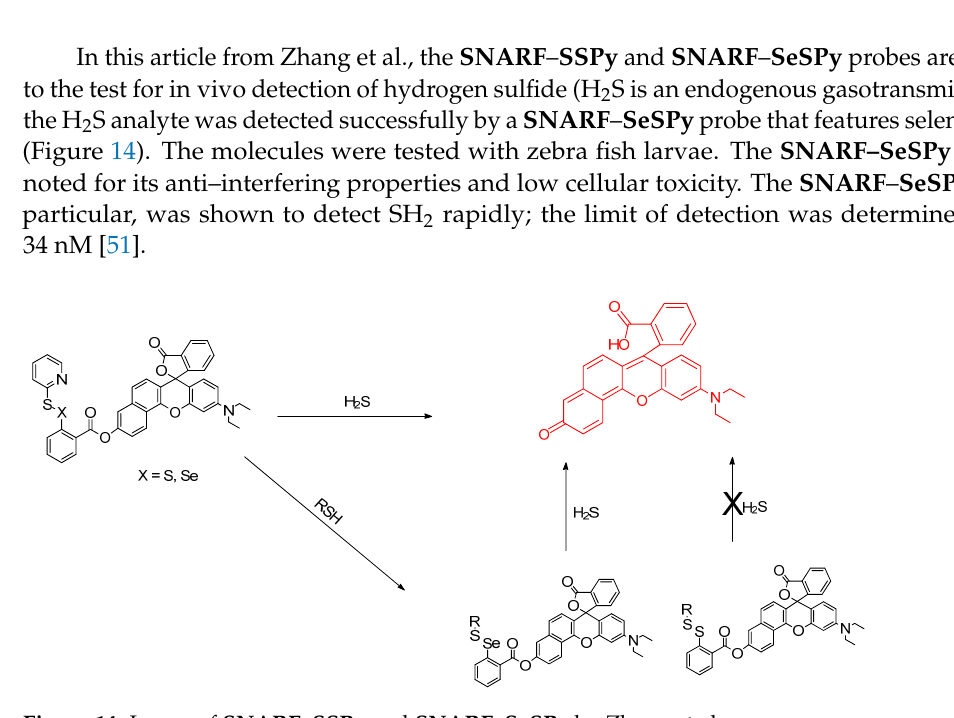
Figure 14. Image of SNARF – SSPy and SNARF – SeSPy by Zhang et al. The report by Huang et al. describes nanodots known as Se–CDs; these molecules are selenium-doped by a certain percentage of carbon nanodots. The optical system was studied as a two–photon species. Free radicals such as OH . and O 2 . − were studied under observation of addition of probe and cellular models (Figure 15). Mitochondria were involved; images of Se were obtained, and changes in fluorescence were observed and discussed. Oxidative stress goes to reduced ROS levels based on the implementation of fluorescence detection. The TPP–Se–CDs labelled Hela cells were also treated with an additional probe: MitoTracker Green. This involved a single (1–photon) monitoring MitoSox Red probe (10 µ M); stimulation was enabled with PMA (phorbol 12–myristate 13–acetate). This probe bears the fluorescence pattern of 540–610 nm, and an excitation at 488 nm [52].